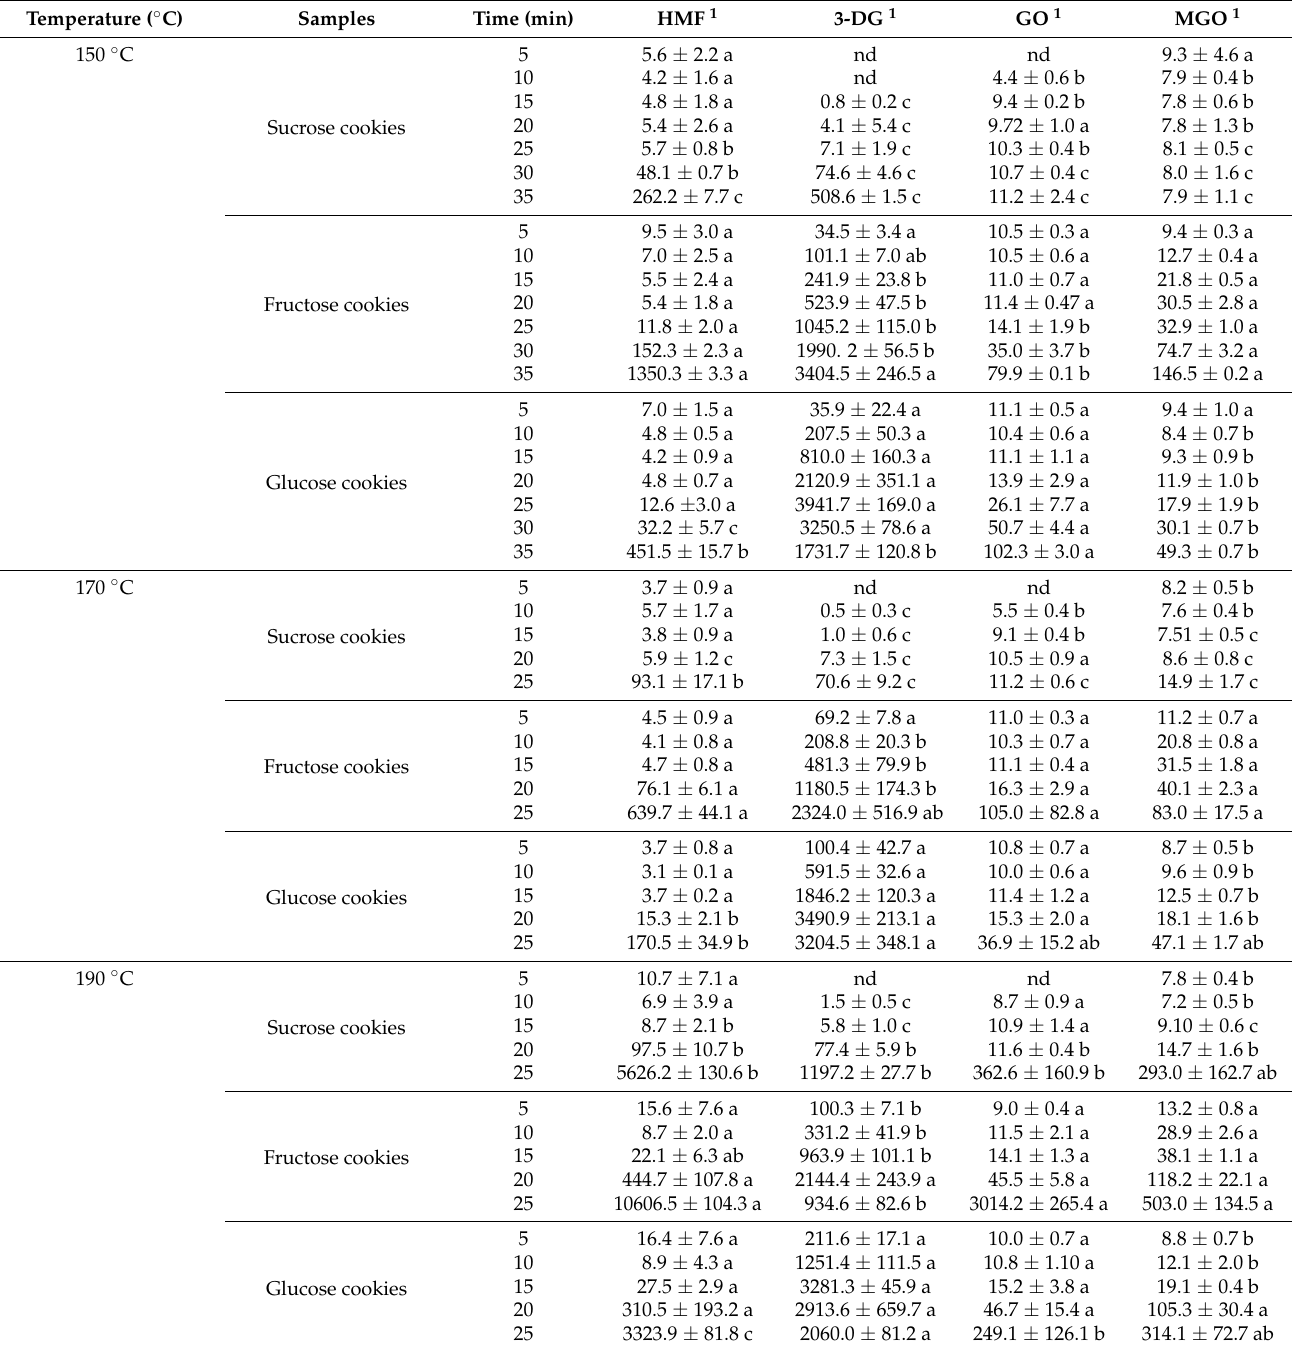
Table 2 summarizes the level of HMF and the DCs in cookie samples as a function of sugar type, temperature and baking time. Table 2. HMF and DC concentration in cookies as a function of the used sugar in the recipe and baking